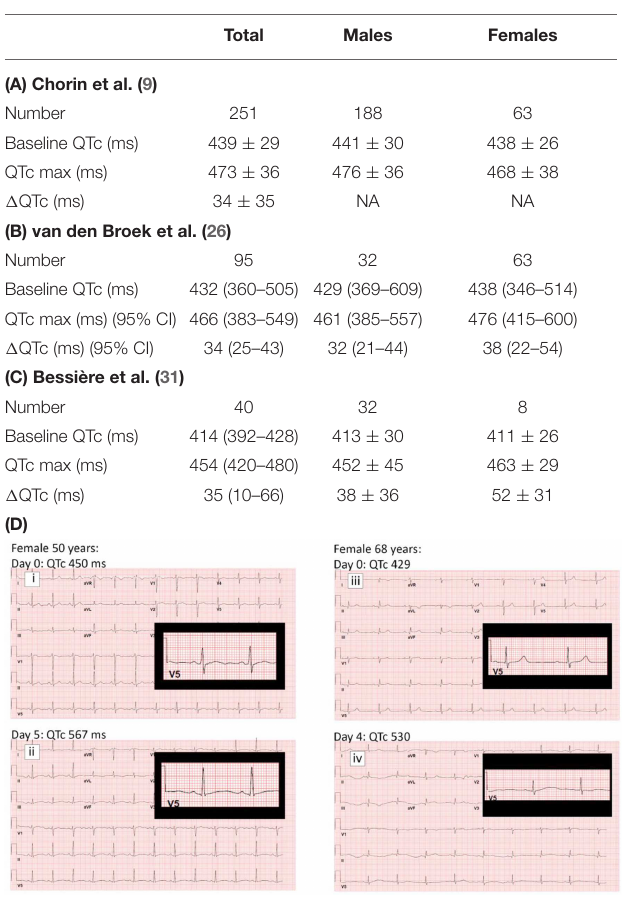
TABLE 2 | (A–C) QTc prolongation comparison in male and female Coronavirus Disease 2019